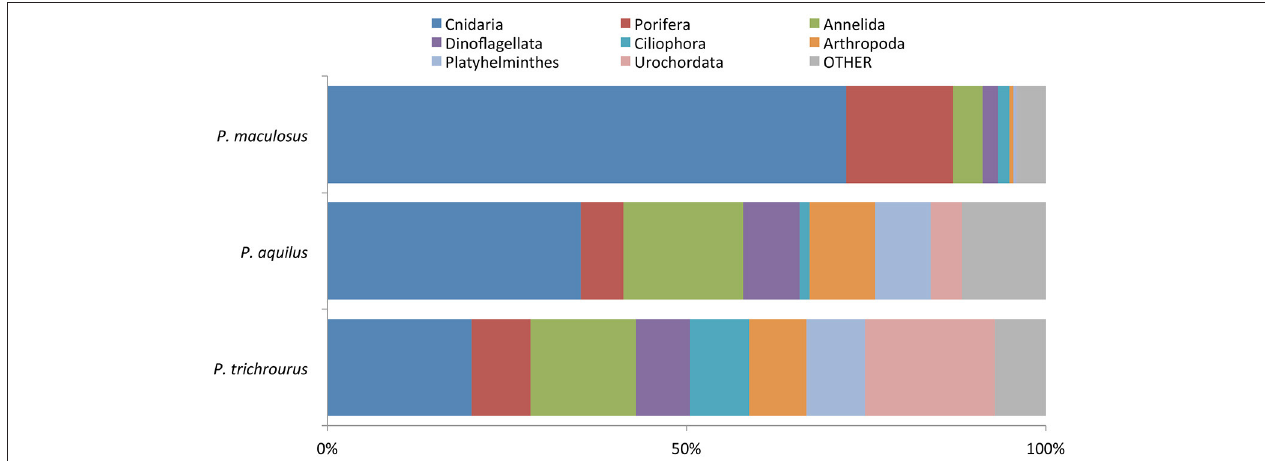
FIGURE 2 | Breakdown of phyla observed in the stomach contents of three reef fish species in Abu Dhabi, UAE, averaged across all sampling periods. The “Other” category is comprised of Cercozoa, Echinodermata, Mollusca, Bryozoa, Apicomplexa and Bolidomonas, each of which was observed in all three fish species at low abundance. See Supplementary Table S3 for means, variances and standard